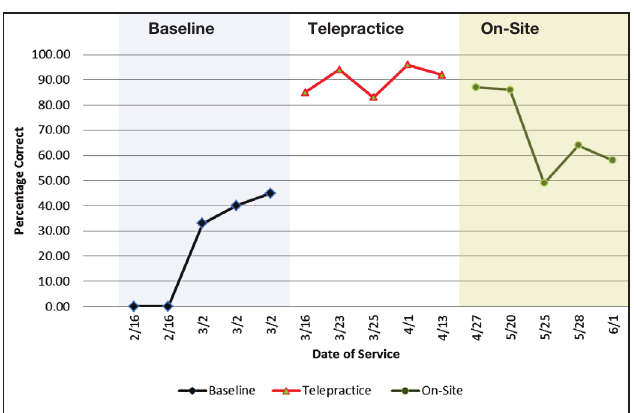
Figure 1: Student Participant’s Documented Progress across the